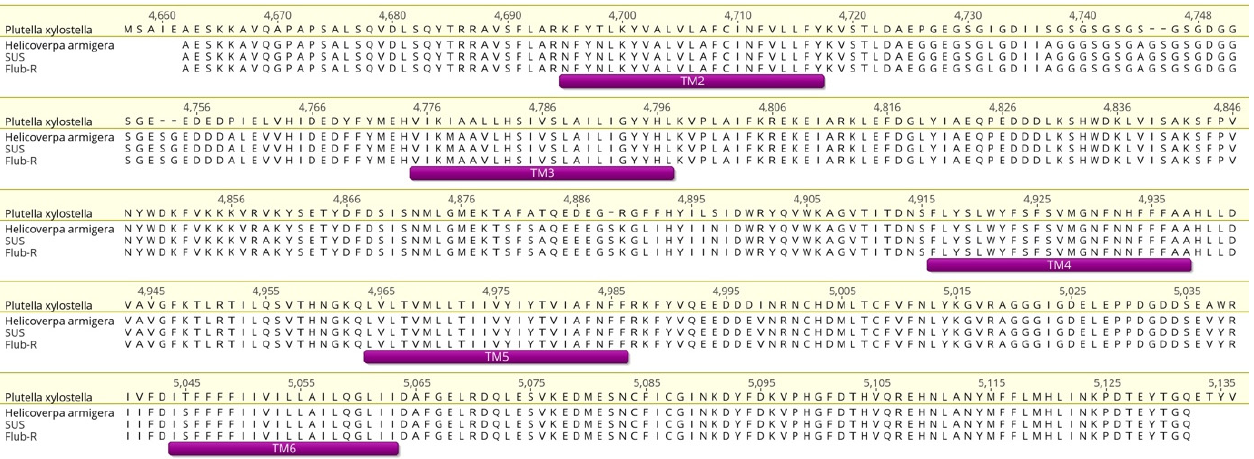
Figure 5. Multiple alignments of partial ryanodine receptors, spanning transmembrane II to VI. This region harbors the main mutations related to diamide resistance. Alignment was performed based on the H. armigera sequence (GenBank AHB33498). No mutations were found in the flubendiamide-resistant strain (Flub-R). The sites are numbered according to the sequence of P. xylostella (GenBank AET09964).